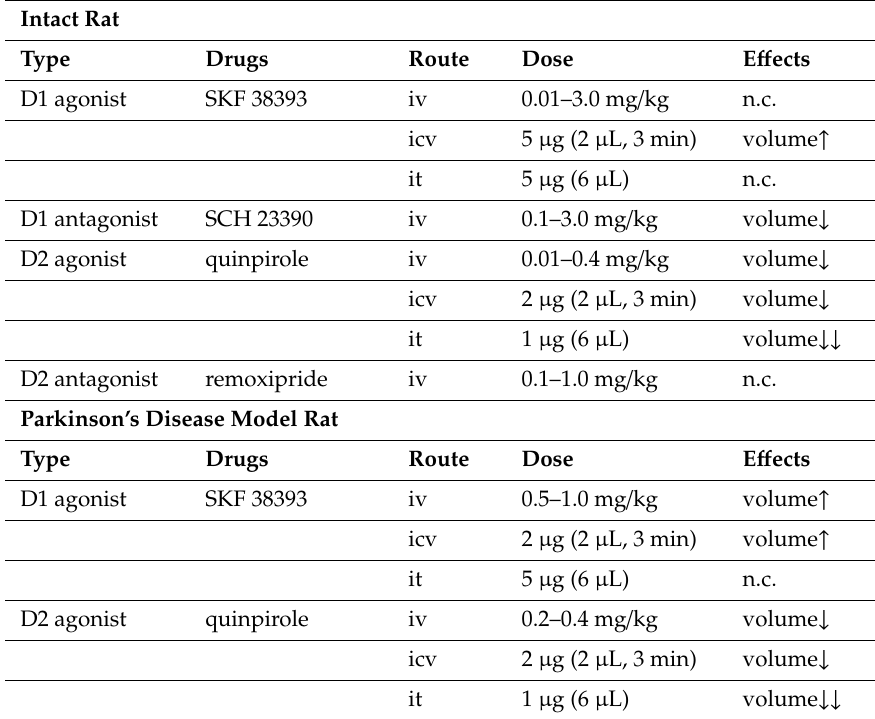
Table 2. E ff ects of each of the dopaminergic agonist / antagonist administration